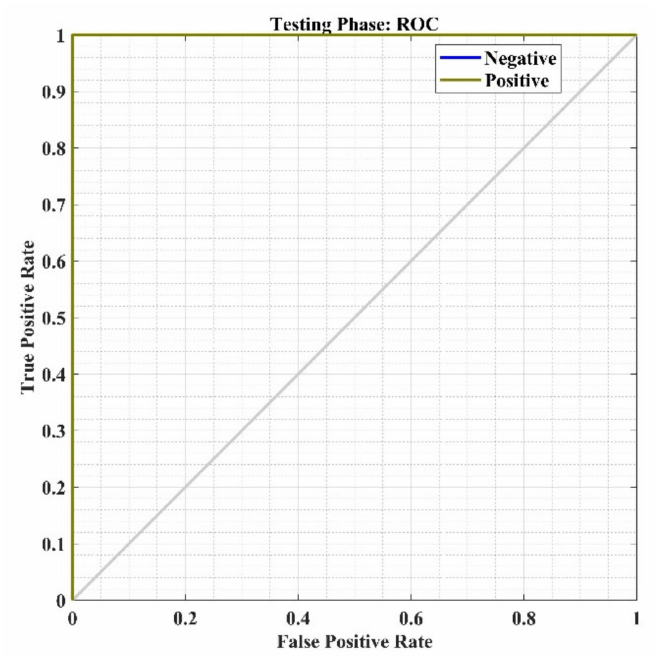
Figure 26. NN’s ROC curve w.r.t. the false-positive rate and true-positive rate during the test- ing